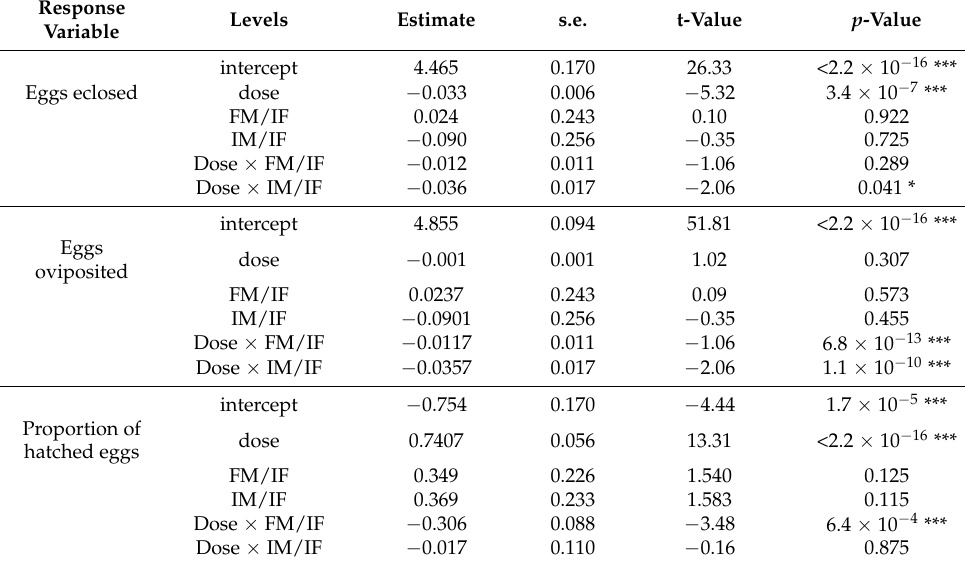
Table 2. Coefficient estimates of the GLiM models for the number of eclosed eggs, the number of oviposited eggs, and the proportion of eggs hatched per female. The IM/FF cross does not appear in the table since this parameter is set to zero and matters as a reference level; thus, the FM/IF and IM/IF estimates are compared with this